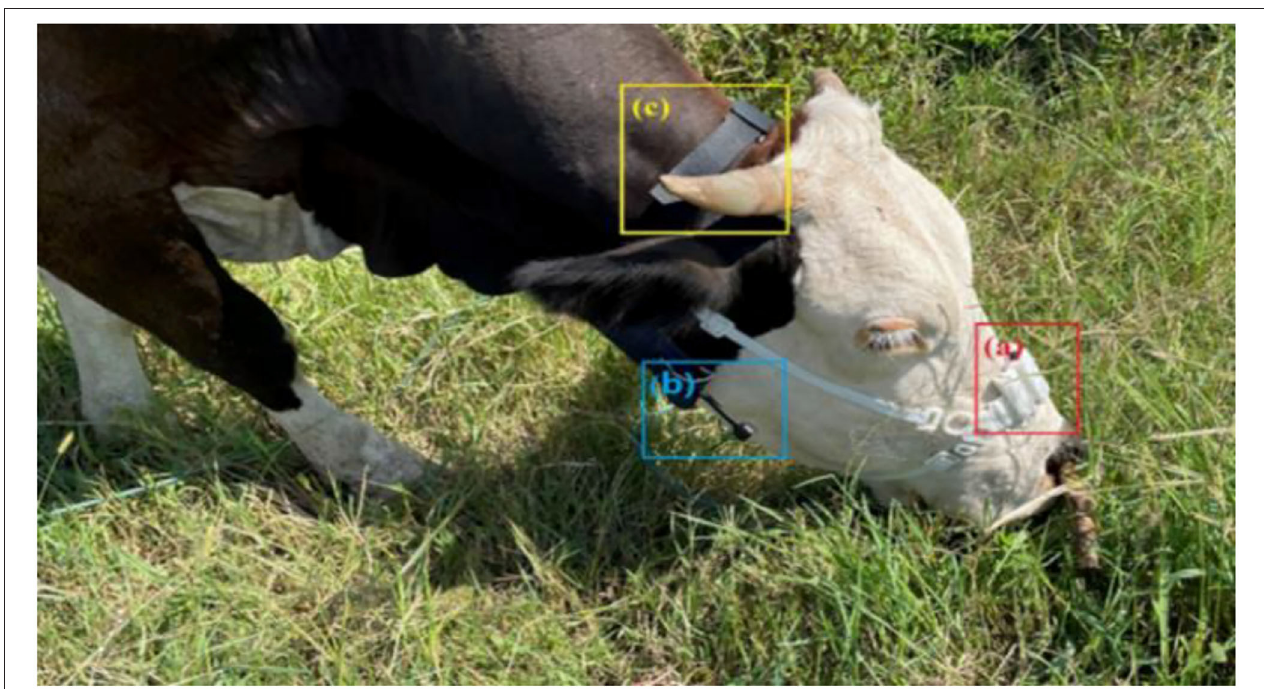
FIGURE 1 | Components of the wearable integrated data acquisition device. (a) Masticatory pressure collecting device, (b) miniature camera, and (c) adjustable wearable